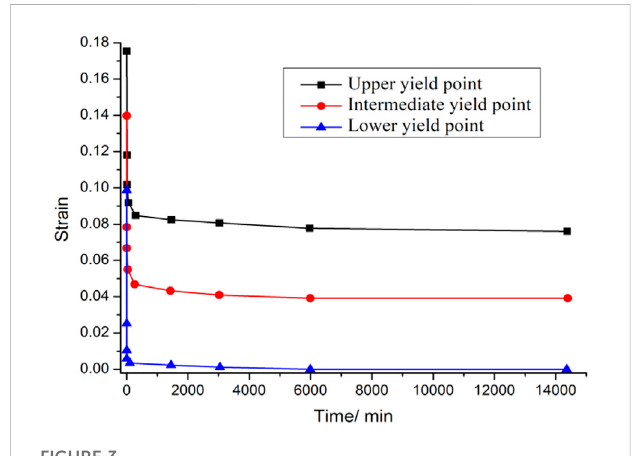
FIGURE 3 Strain curves of PMMA specimens after elastic unloading.